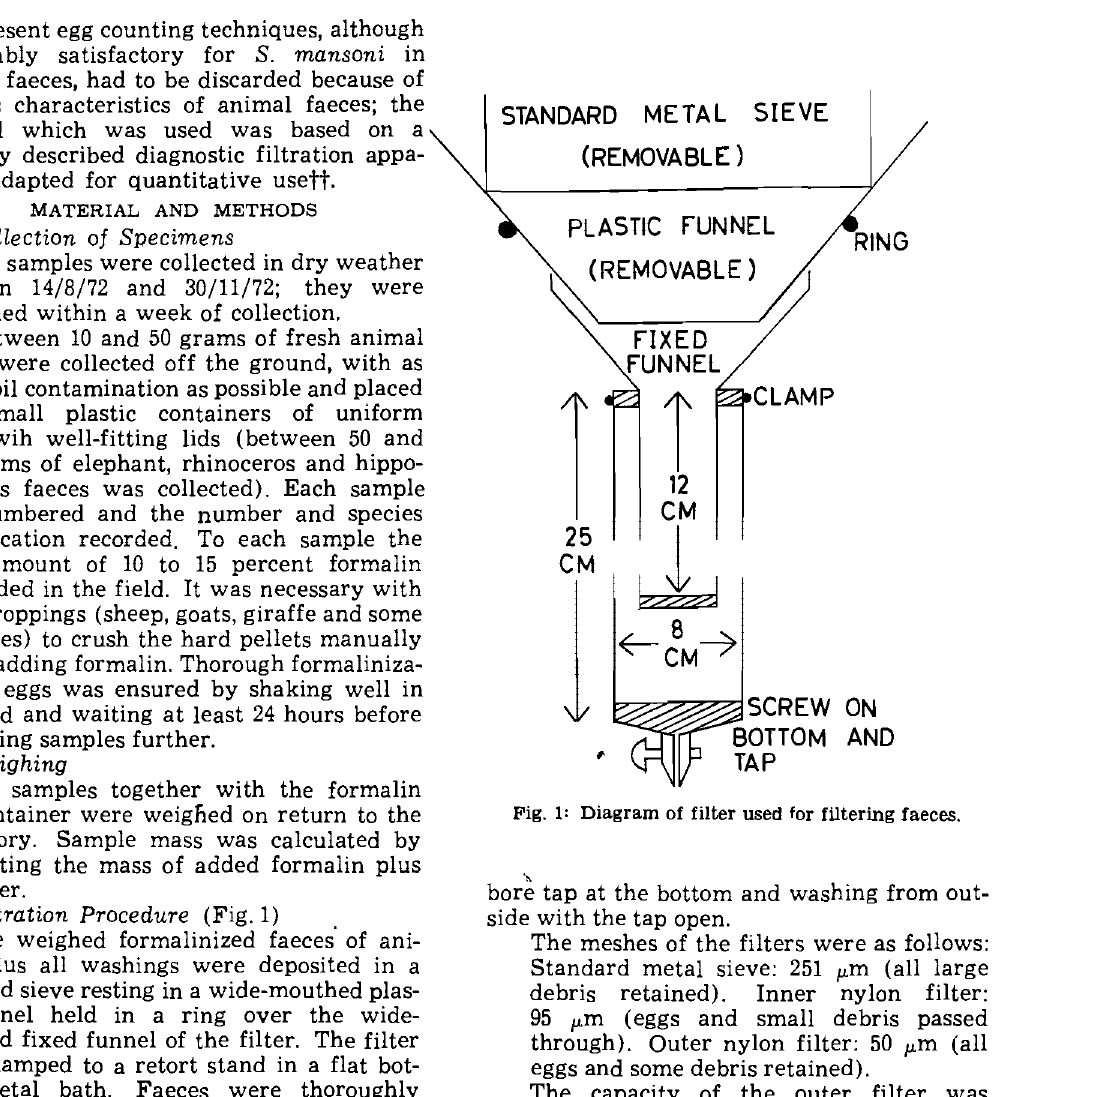
Fig. 1: Diagram of filter used for filtering